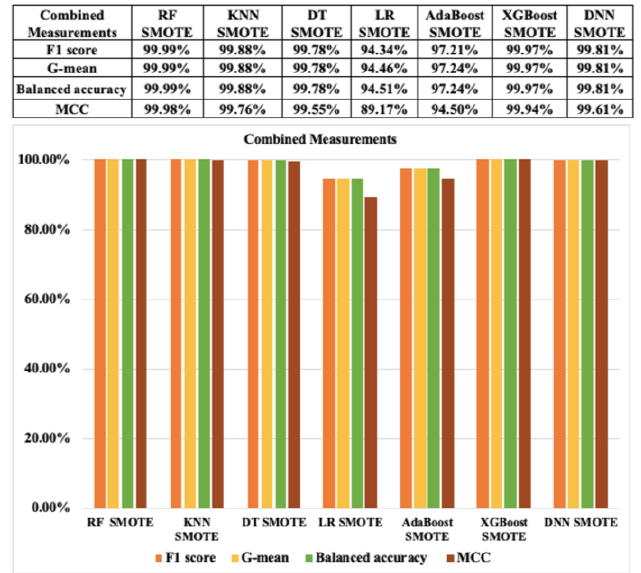
Figure 14. Combined classification performance measurements with SMOTE based on resampling approach 1.